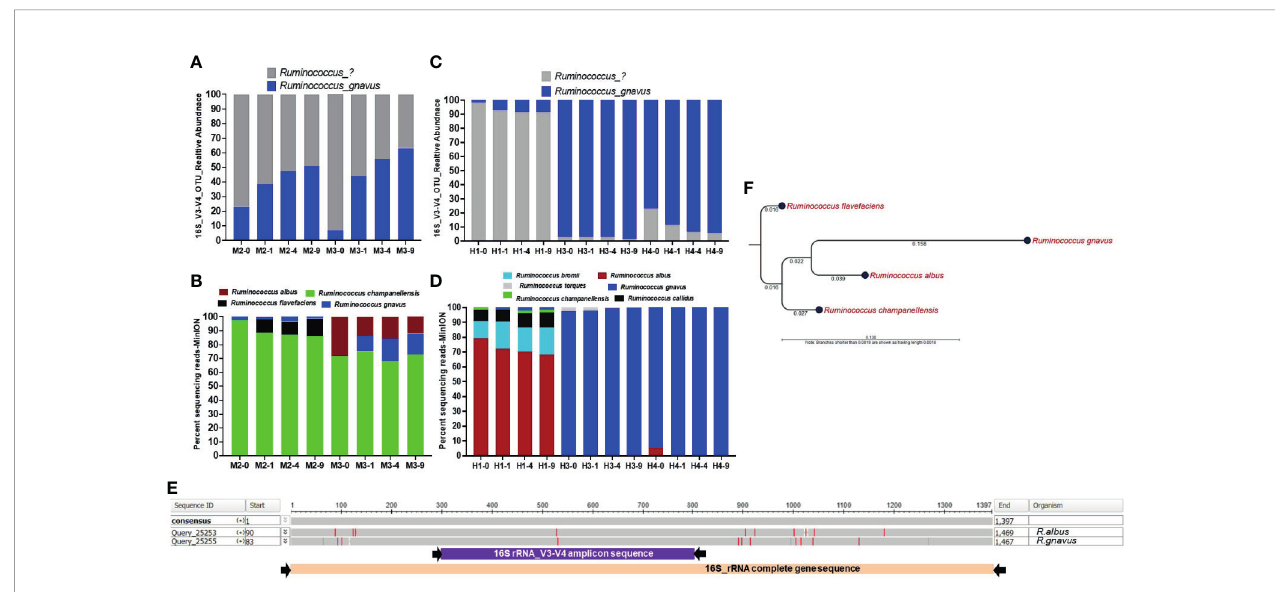
FIGURE 6 | Bead-beating intensity impacts recovery of Ruminococcus species. Panel (A) Bar plots show abundance of Ruminococcus in v3-v4 amplicon data in mouse stool. Panel (B) shows full length 16S rRNA sequencing data in mouse stool. Panel (C) Bar plots show v3-v4 amplicon data-based abundance of Ruminococcus in human stool. Panel (D) shows the proportion of various Ruminococcus species detected by full length 16S rRNA sequencing data in human stool. The x-axis shows the sample number and four different bead-beating conditions 0 min, 1 min, 4 min, and 9 min. The y-axis for panels (B, D) shows the percentage of full length 16S rRNA sequencing reads that support the detected taxon in the 16S analysis EPI2ME-WIMP pipeline. Panel (E) Nucleotide sequence alignment on the 16S rRNA gene sequence of Ruminococcus albus and Ruminococcus gnavus using NCBI ’ s BLASTn program. The presented image was generated from Multiple Sequence Alignment Viewer 1.20.0. The grey horizontal bar represents conserved 16S rRNA gene sequences and red lines indicate mismatches or differences between two sequences. Purple and pink bars underneath show v3-v4 amplicon and full length 16S rRNA primer-captured gene regions, respectively. Panel (F) 16S rRNA gene sequence-based maximum likelihood phylogenetic tree. Complete 16S rRNA gene sequence of Ruminococcus albus , Ruminococcus gnavus, Ruminococcus champanellensis , and Ruminococcus fl avefaciens were aligned and the maximum likelihood phylogenetic tree was constructed using CLC Genomic workbench 12.0.2. Numbers on the tree indicate branch length calculated based on the number of